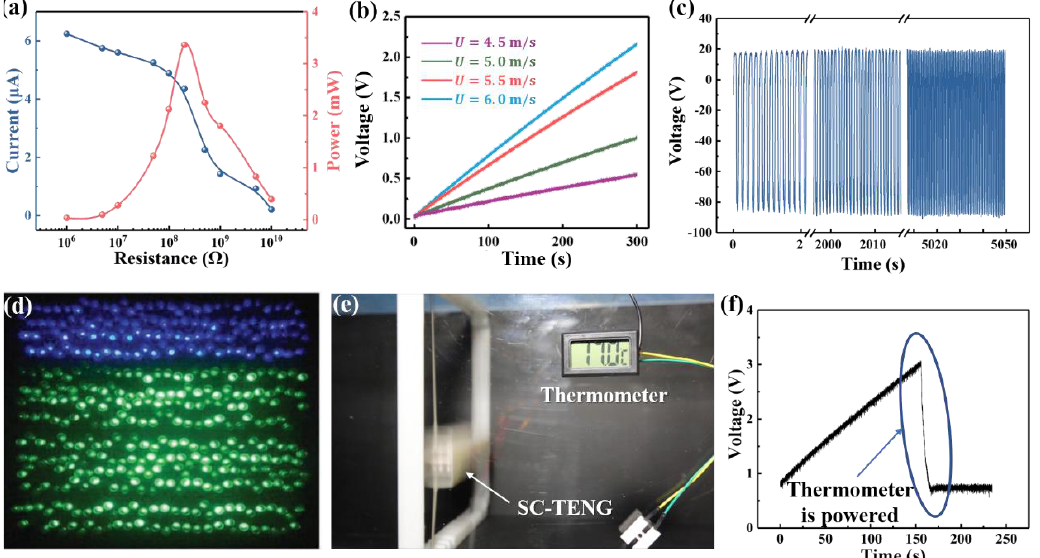
Figure 5. Demonstration of the SC − TENG. ( a ) The output current and the power of the SC − TENG with respect to resistance in the circuit; ( b ) charge curve of the SC − TENG under different velocities; ( c ) durability test of the SC − TENG; ( d ) more than 200 LED light bulbs are lit by the SC − TENG; ( e ) a thermometer powered by SC − TENG; ( f ) the charge-discharge curve of the SC − TENG system powering thermometer.